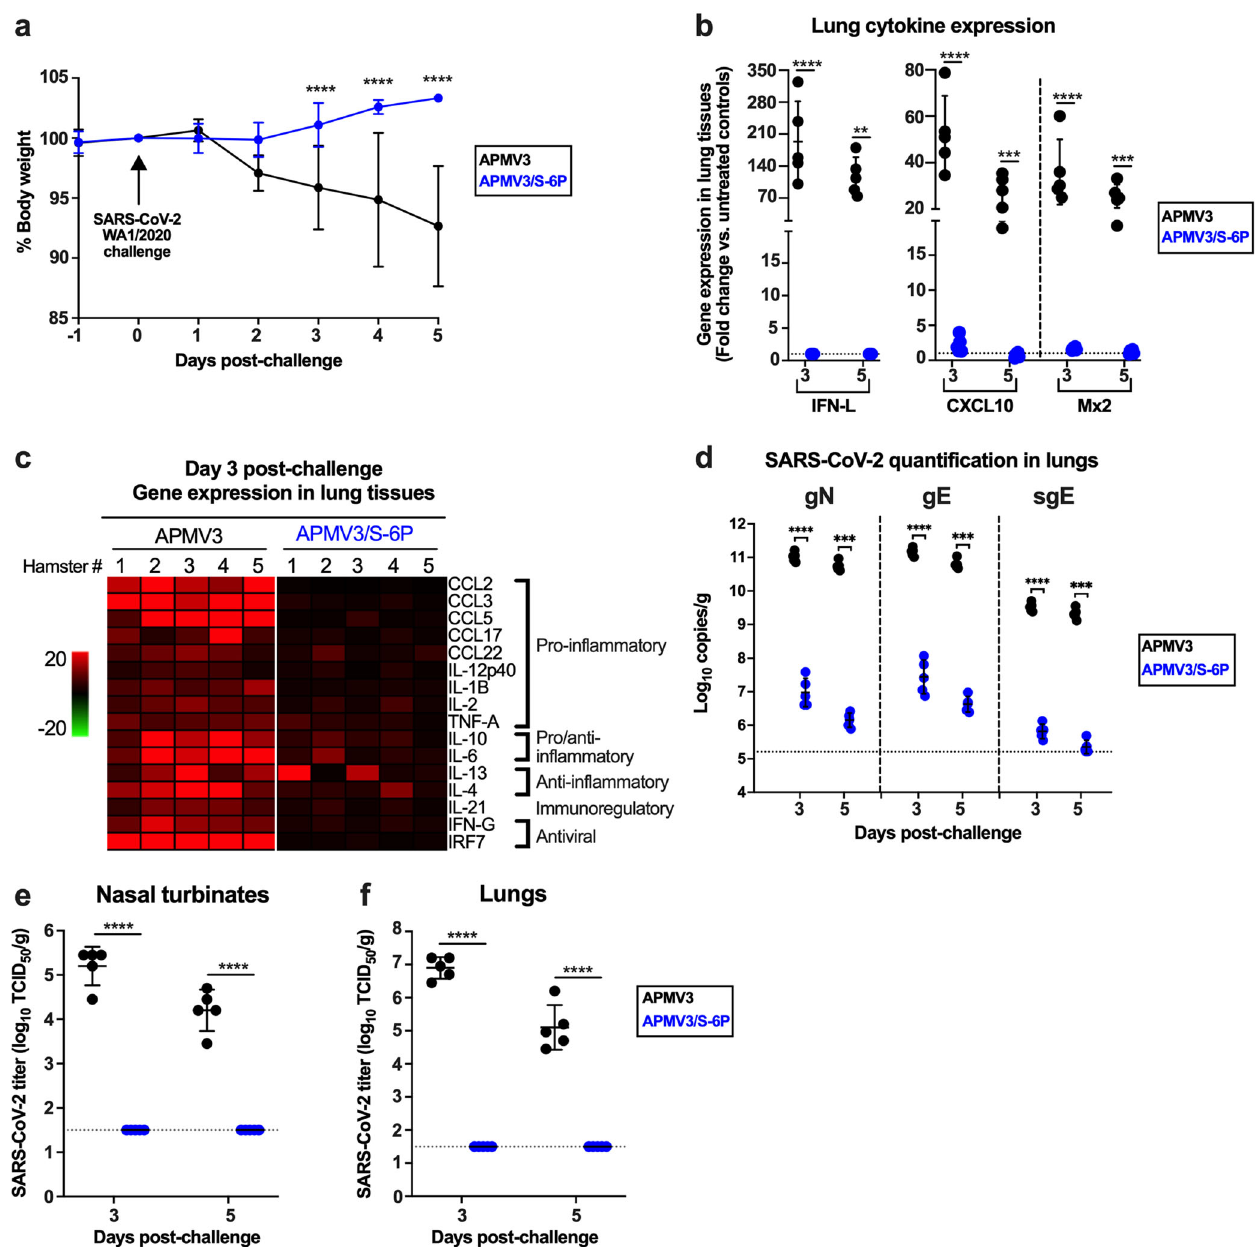
Fig. 5 Protective ef fi cacy of APMV3/S-6P against a SARS-CoV-2 challenge (from Experiment #2). As part of Experiment #2 (see Fig. 4a for the timeline) hamsters ( n = 10 per group) immunized intranasally with 6 log 10 PFU per animal of APMV3/S-6P or APMV3 were challenged intranasally on day 30 with 4.5 log 10 TCID 50 per animal of the SARS-CoV-2 WA1/2020. a Body weights were measured from day -1 to day 5 post-challenge and expressed as % body weight relative to the day 0 time point ( n = 10 hamsters per group from day -1 to day 3 and n = 5 hamsters per group from day 4 to day 5). The means and SD are shown. **** p ≤ 0.0001, mixed effects analysis with Sidak post-hoc test. b – f Five hamsters per group were euthanized on days 3 and 5 post-challenge, and NTs and lungs were harvested, homogenized, and aliquots were snap-frozen until further processing. b – c Total RNA was extracted from lung homogenates and subjected to TaqMan RT-qPCR to evaluate the expression of selected genes related to in fl ammatory/antiviral responses. qPCR data were analyzed using the ΔΔ Ct method, normalized to β -actin, and expressed as fold-change over the average expression levels of three mock-immunized, mock-challenged hamsters. The three most up-regulated genes (IFN-L, CXCL10 and Mx2) are shown in ( b ) while the relative expression levels of the remaining 16 genes on day 3 after challenge are shown in ( c ) as a heat map ( n = 5 per group). ** p ≤ 0.01, *** p ≤ 0.001 and **** p ≤ 0.0001, two way ANOVA with Sidak post-hoc test. The means and SD are shown in ( b ). d RT-qPCR quanti fi cation of the SARS-CoV-2 genomic N (gN), genomic E (gE)